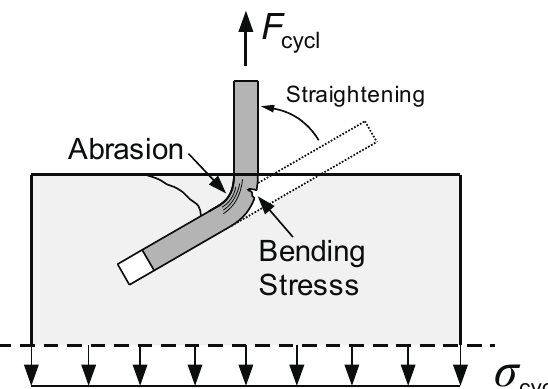
Figure 5. Degradation effects caused by pullout of inclined fibre.